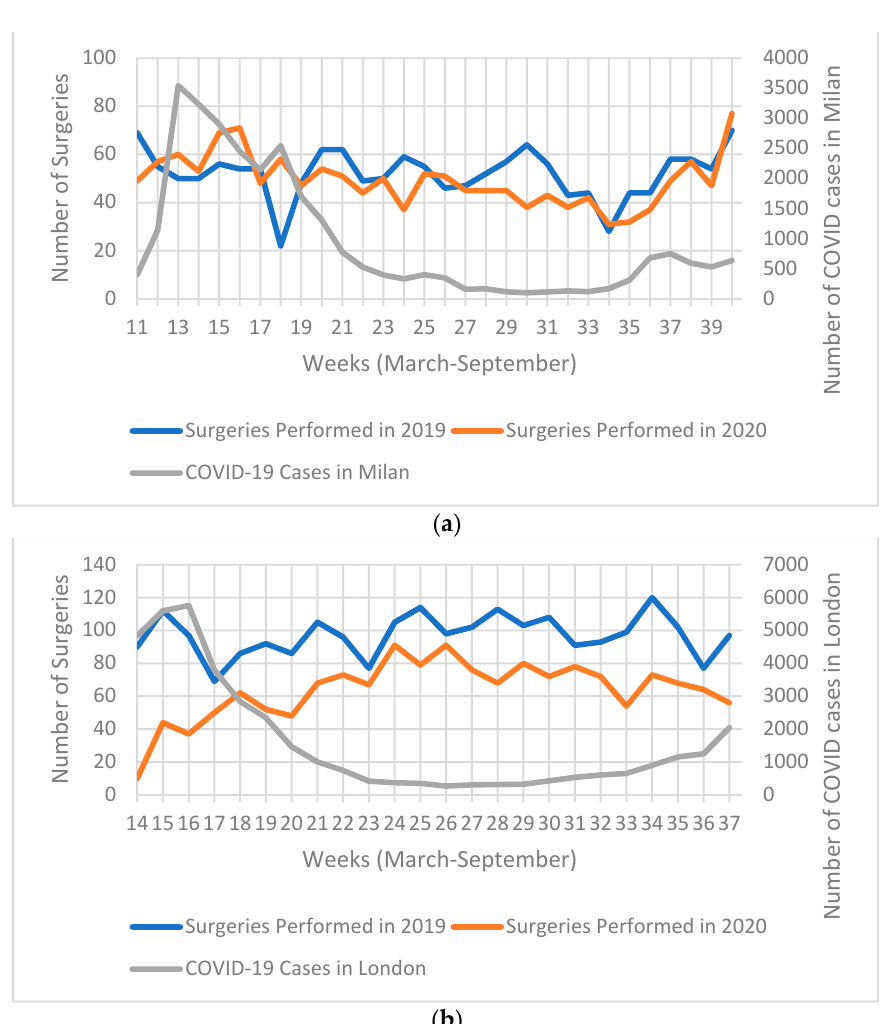
Figure 1. Chart illustrating: ( a ) weekly COVID-19 cases in Milan (and metropolitan area), and number of surgeries 01/03/20–30/09/20; ( b ) weekly SARS-CoV-2 (COVID-19) cases in London (and metropolitan area), and number of surgeries performed in South East London Cancer Alliance (SELCA) between 23/03/19–08/09/19 and 23/03/20–08/09/20. Table 1. European Institute of Oncology, IRCCS (IEO) patient characteristics of cancer patients receiving radical surgery between 01/03/19–30/09/19 and 01/03/20–30/09/20, divided by cancer site.